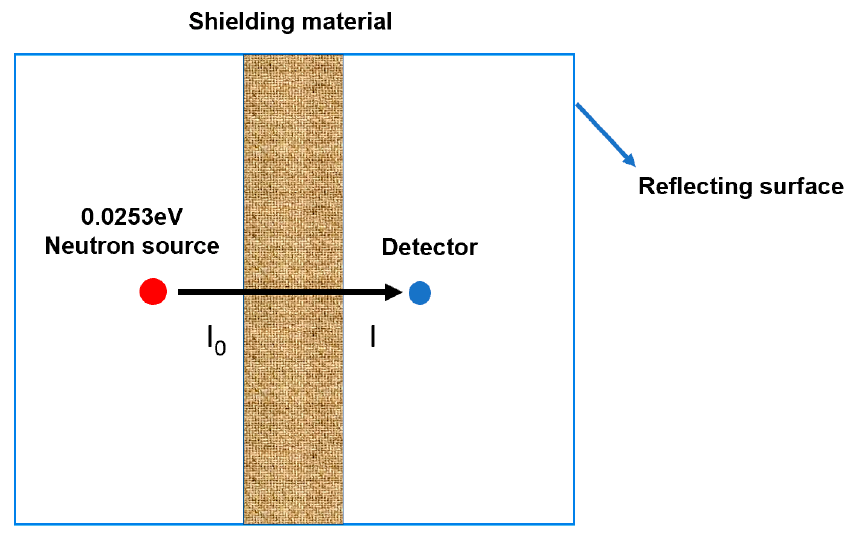
Figure 12. Schematic diagram of one-dimensional neutron shielding model. Table 3. The isotopic composition and thermal neutron cross-section of natural